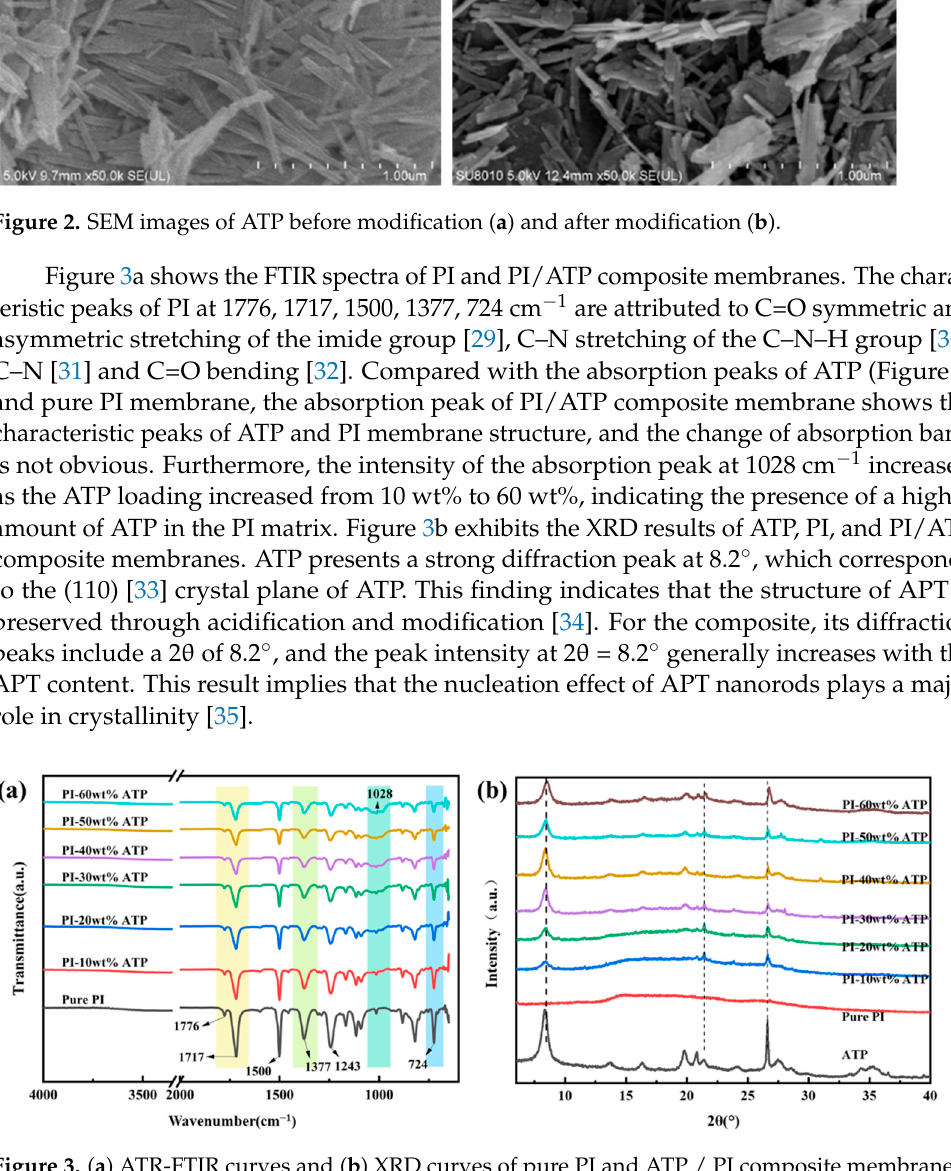
Figure 1. FTIR spectra of ATP before and after modification.